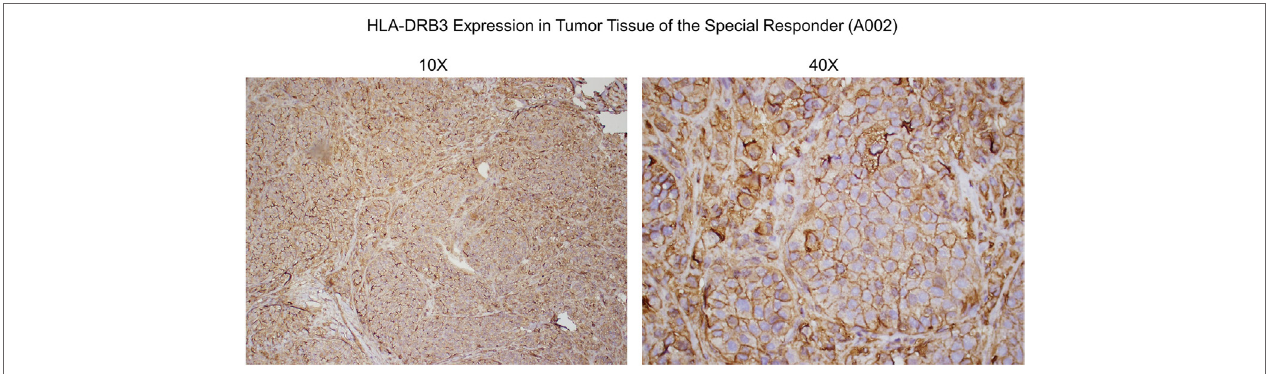
FigUre 6 | Anti-HLA-DR β 3 antibody staining of a tumor specimen from the strong clinical responder. To assess whether the strong clinical responder (16), referred to as subject A002 in this article, presented with tumor expression of HLA-DR β 3, paraffin-embedded A002 tumor material was stained with a rabbit polyclonal antibody raised against an N-terminal region of human HLA-DR β 3. As demonstrated, immunoreactivity was apparent.